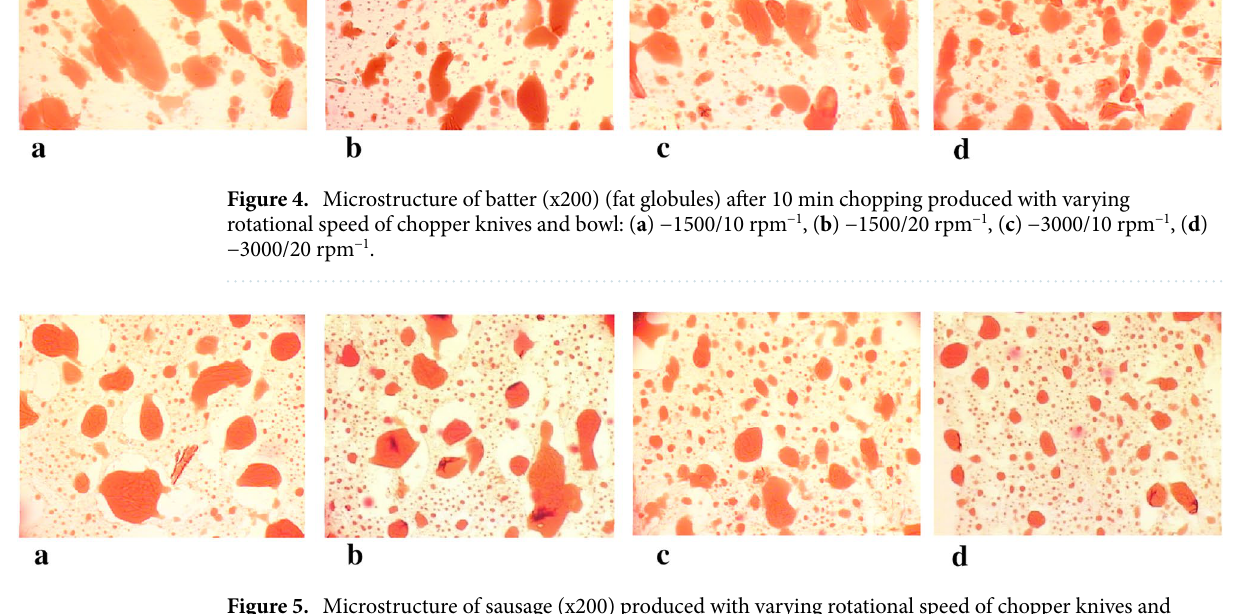
Figure 5. Microstructure of sausage (x200) produced with varying rotational speed of chopper knives and bowl: ( a ) −1500/10 rpm −1 , ( b ) −1500/20 rpm −1 , ( c ) −3000/10 rpm −1 , ( d ) −3000/20 rpm −1